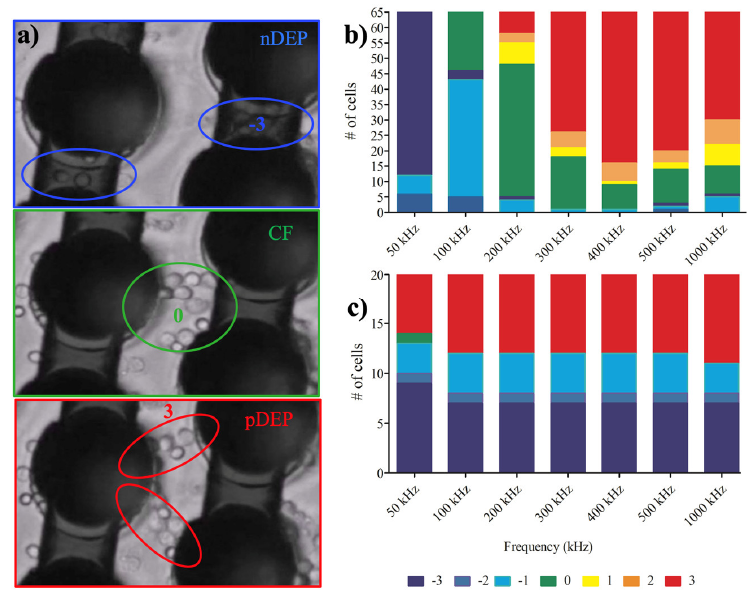
Figure 2. Dielectrophoretic responses of monocytes and macrophages: ( a ) Positions of the cells in the electrode array when they are influenced by nDEP, crossover frequency (CF) and pDEP, respectively; ( b ) Translational movement of U937 monocytes under 20 Vpp, 50 kHz–1 MHz nonuniform AC field; ( c ) Translational movement of U937-differentiated macrophages under 10 Vpp, 50 kHz–1 MHz nonuniform AC field. The cool colors show the number of nDEP- behaved cells due to repelling DEP forces while the warm colors demonstrate pDEP-responded cells owing to attractive DEP forces. Zero means the crossover frequency with zero movements, which is coded in green color. n = 80 for monocytes, n = 30 for macrophages.